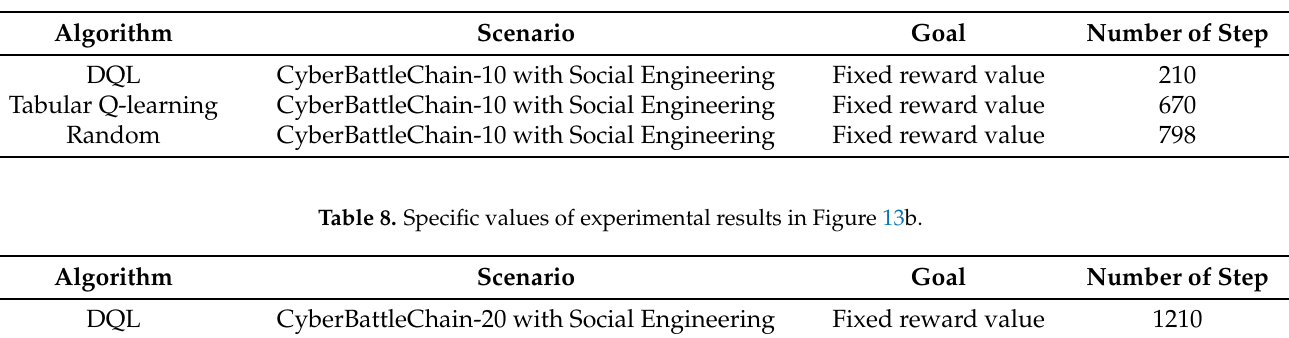
Table 7. Specific values of experimental results in Figure 13a.